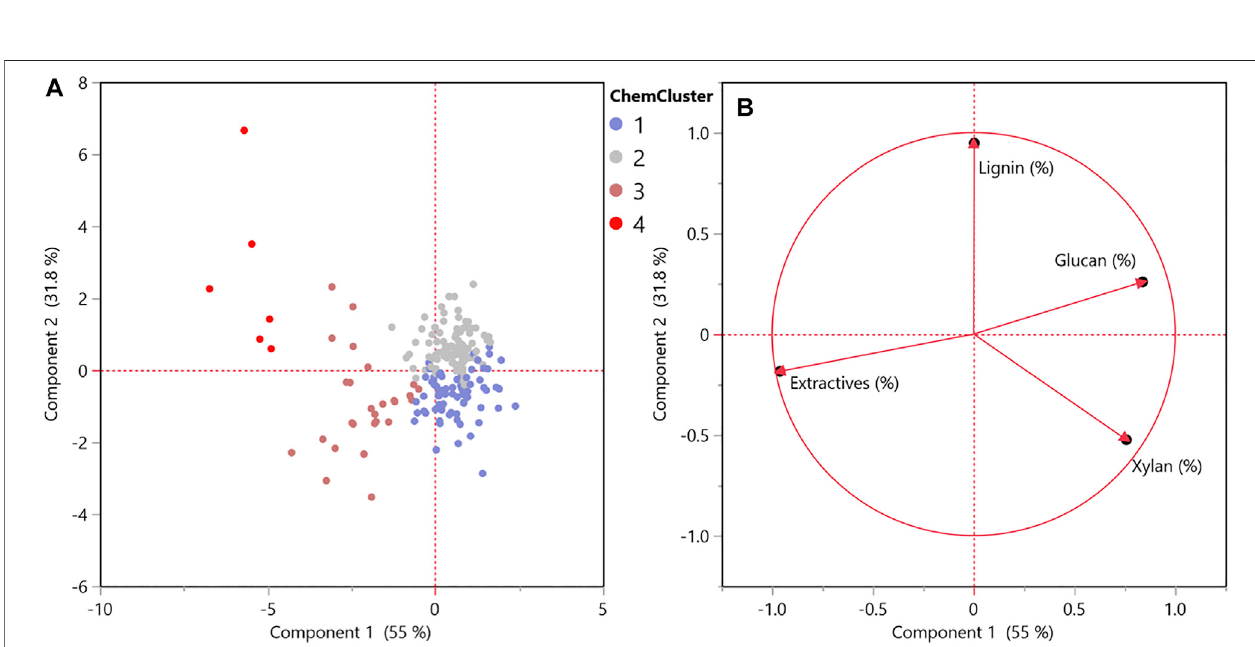
FIGURE 3 | Principal component analysis of biological degradation (A) score plot and (B) loading plot for chemical composition. n = 222.